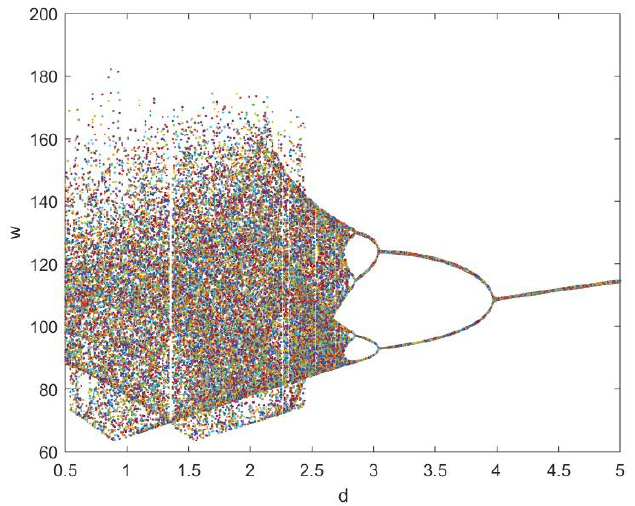
Figure 1. Bifurcation diagram of system (11).